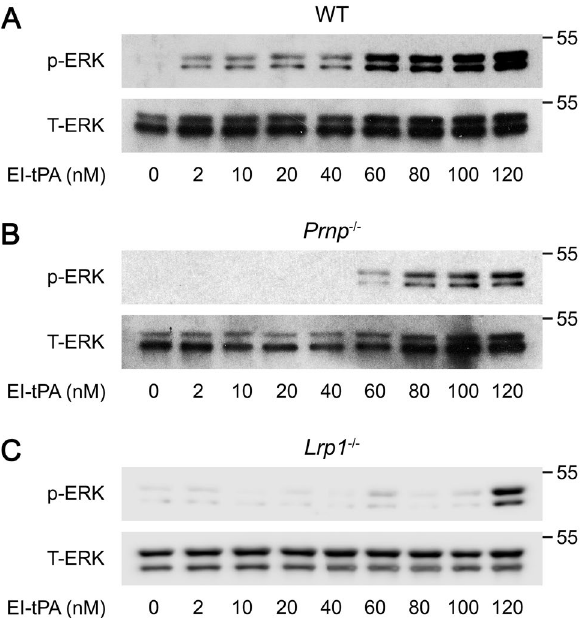
Figure 3. Deletion of the genes encoding membrane-anchored PrP C or LRP1 in BMDMs decreases the concentration of EI-tPA required for activation of ERK1/2. ( A ) BMDMs isolated from WT mice were treated for 1 h with increasing concentrations of EI-tPA (2–120 nM). Cell extracts were subjected to immunoblot analysis to detect phospho-ERK1/2 and total ERK1/2. (B) PrP C -deficient BMDMs isolated from Prnp −/− mice were treated for 1 h with increasing concentrations of EI-tPA (2–120 nM). Cell extracts were subjected to immunoblot analysis to detect phospho-ERK1/2 and total ERK1/2. (C) LRP1-deficient BMDMs from m Lrp1 −/− mice were treated for 1 h with increasing concentrations of EI-tPA (2–120 nM). Cell extracts